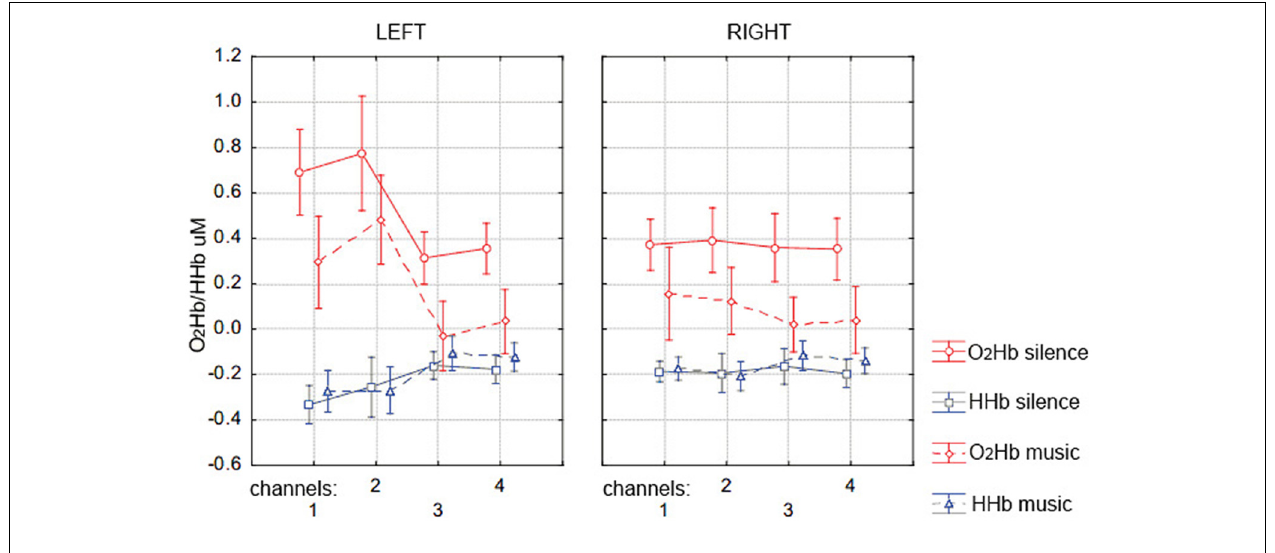
FIGURE 4 | Mean ( ± SD) of the prefrontal cortex max-O 2 Hb (red lines) and min-HHb (blue lines) concentration values over the left (channels 1, 2, 3, and 4, corresponding to EEG channelsAF7, F5,AF3, F3) and right